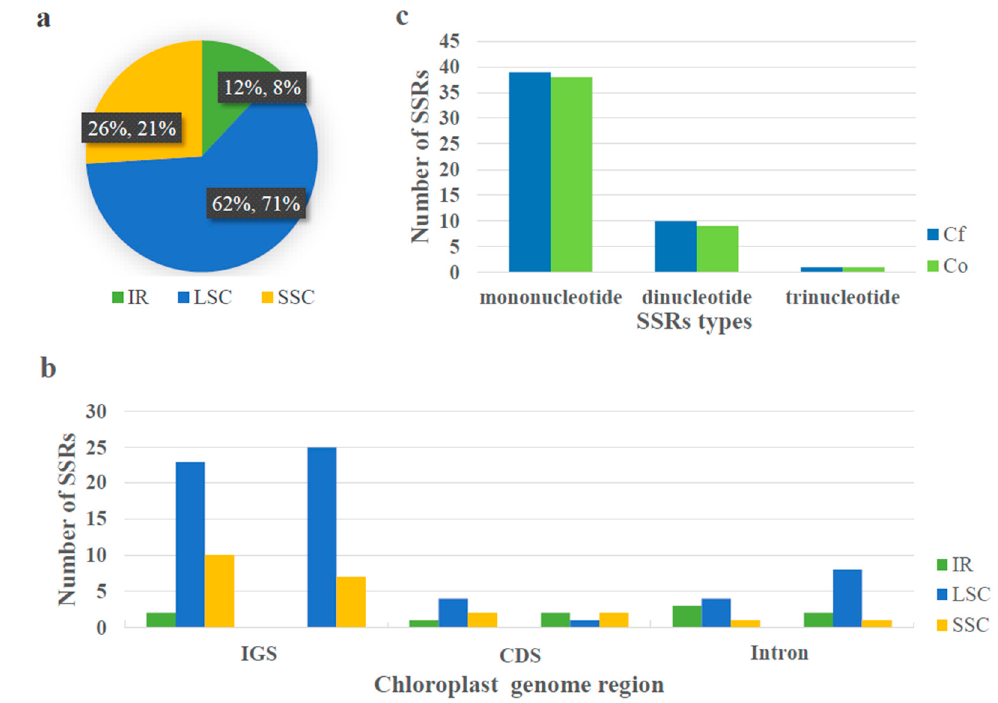
Figure 2. The distribution, type, and presence of simple sequence repeats (SSRs) in the chloroplast genomes of C. fimbriata (left) and C. ovalis (right). ( a ) Presence of SSRs in the regions of large single-copy region (LSC), small single-copy region (SSC) and inverted regions (IRs). ( b ) Presence of SSRs in the intergenic spacer (IGS), coding region (CDS), and Intron of LSC, SSC, and IRs regions. ( c ) Presence of the numbers of polymers.